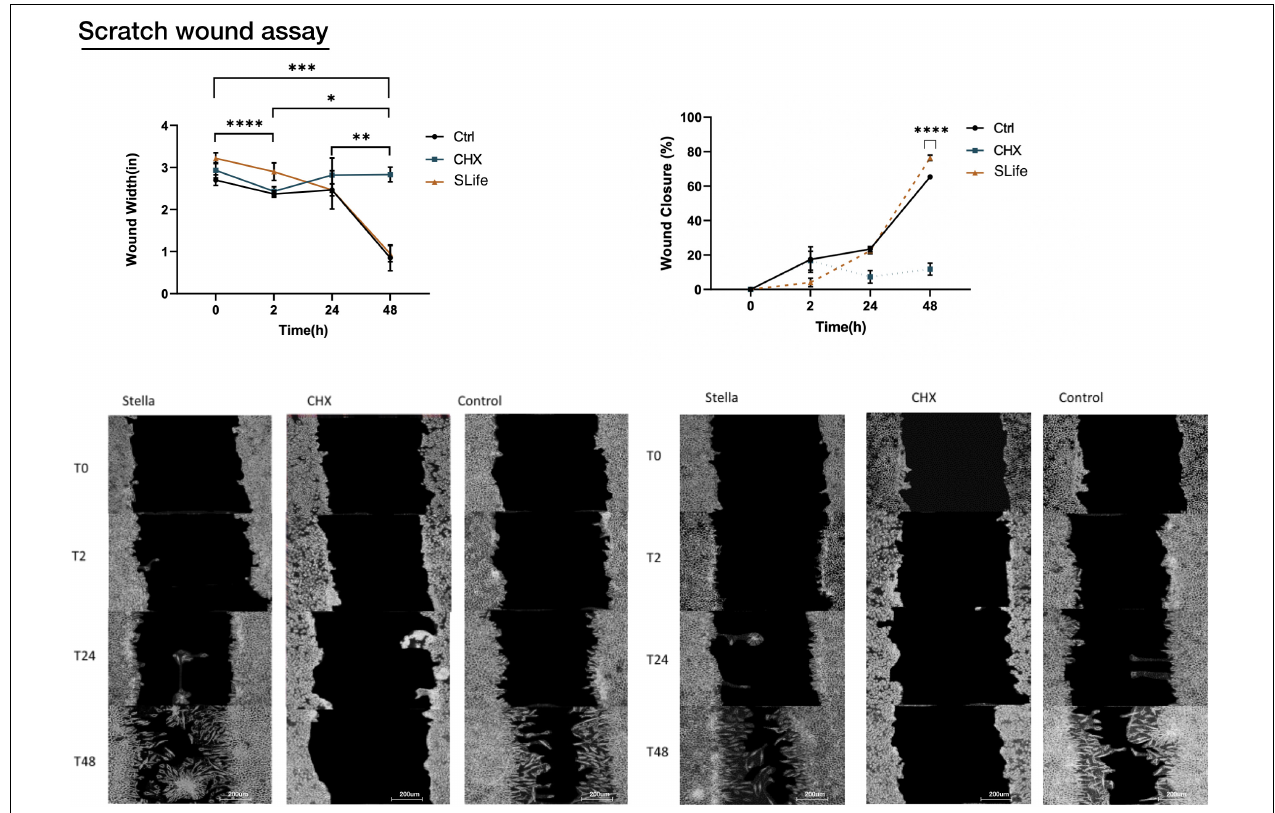
FIGURE 4 | Images of the scratch wounds at two representative regions of interest for each of three conditions are shown at various timepoints following initial incubation (0 h, 2 h, 24 h, and 48 h). SLife group was compared to active comparator CHX as a positive cytotoxic control and against a media only control condition to monitor wound healing in the absence of external factors. Because of cytotoxic effect the CHX condition indicated a wound that remains relatively the same size throughout the assay with exfoliation of cells noted at 2–24 h, which hindered cell migration. SLife led to a slightly more rapid wound closure compared the control, although not significantly different. Asterisks designate significant differences p < 0 . 05. Ascending numbers of asterisks used to differentiate comparisons between increasing timepoint intervals.